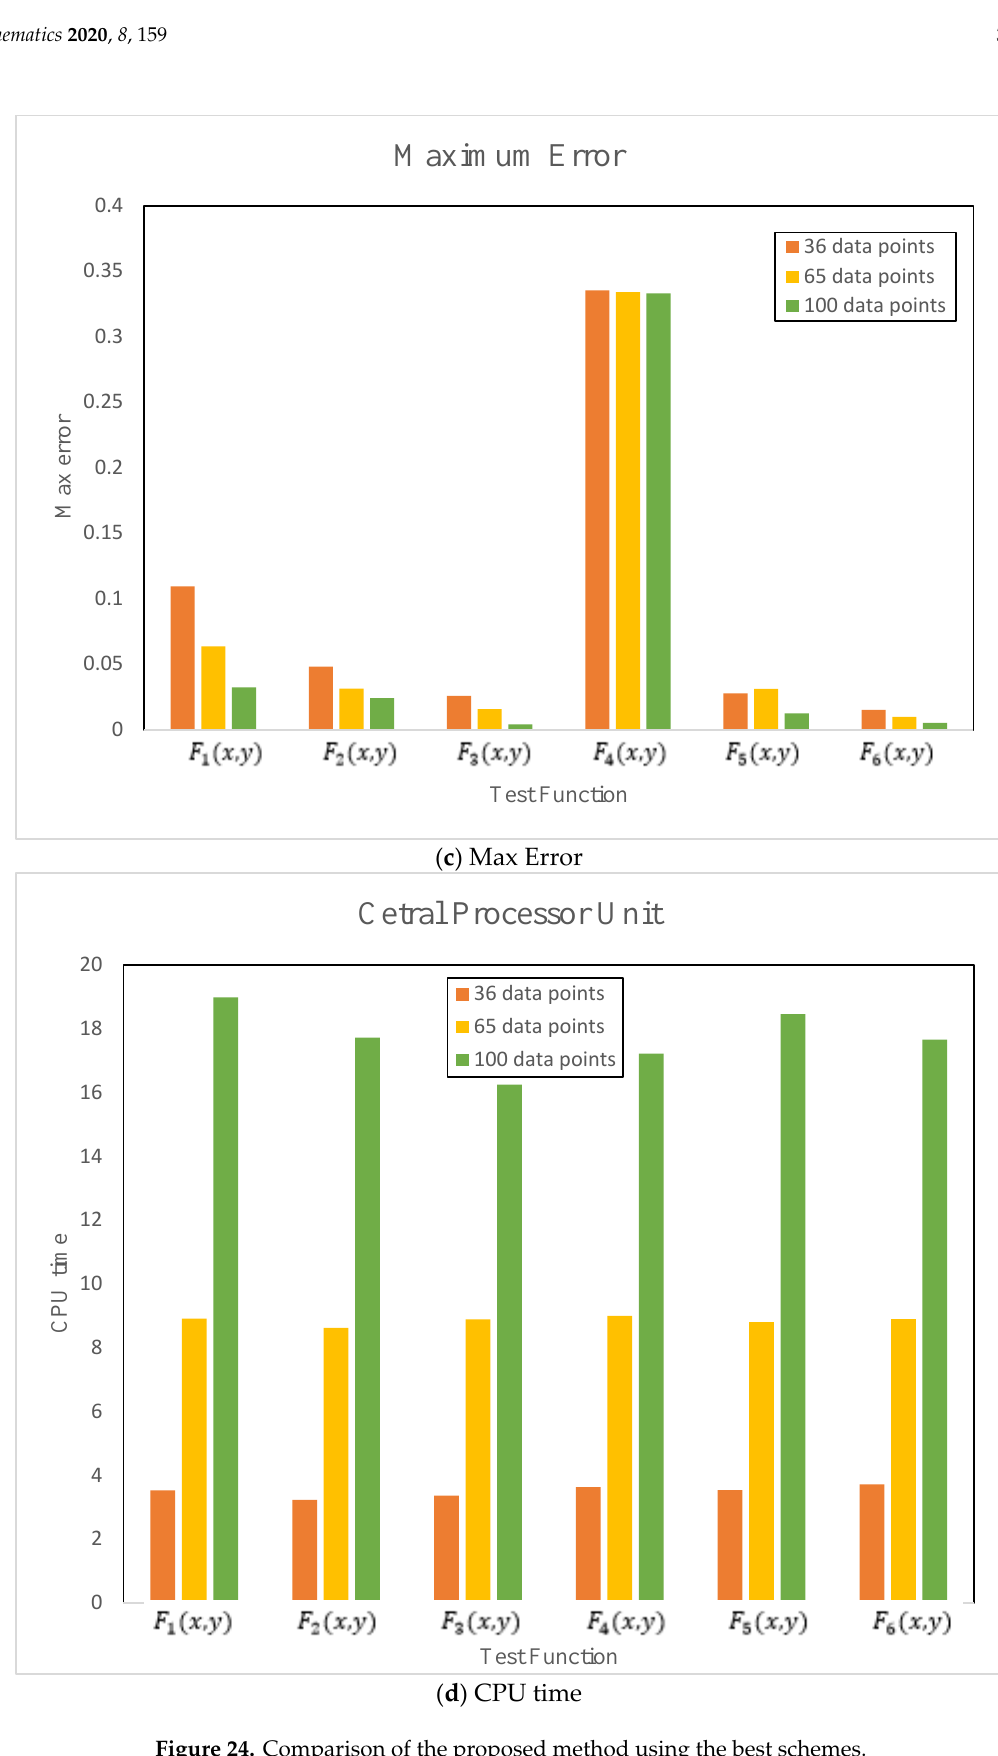
Figure 24. Comparison of the proposed method using the best schemes.